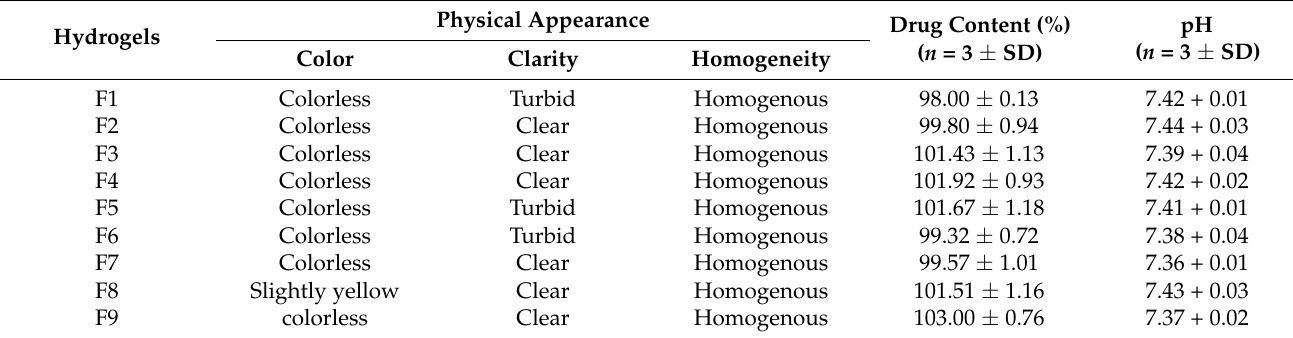
Table 2. Physical appearance, drug content, and pH of